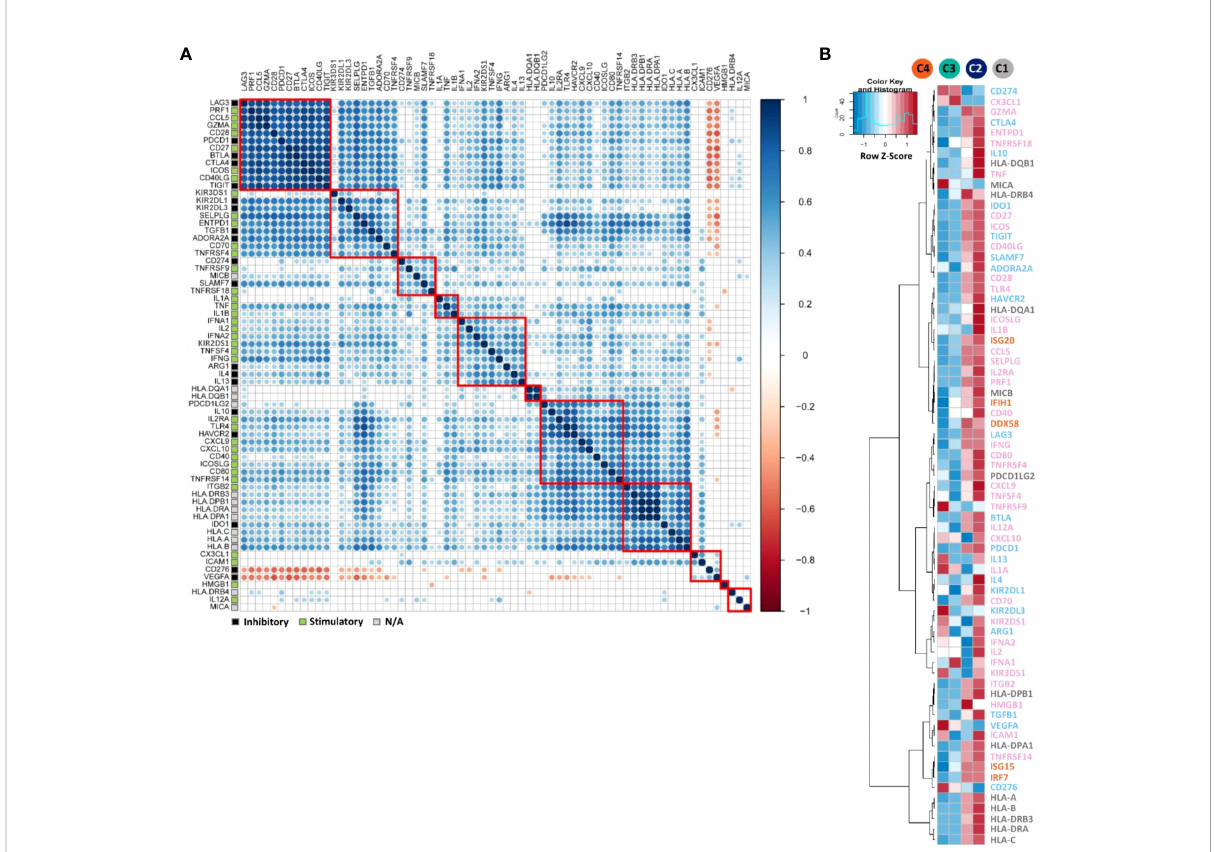
FIGURE 4 Correlation and expression analyses of immunomodulator genes. (A) Pearson correlation matrix showing the clustering and correlations of 68 immunomodulator genes. The correlation matrix was subjected to unsupervised hierarchical clustering using Euclidean distance measurement. Blue dots illustrate positive correlations, white ones no correlation (FDR ≥ 0.01), and red negative correlations. Bigger dot size indicates a smaller p-value of the correlation. Red squares indicate the individual clusters. Different gene modulatory functions were annotated in coloured squares on the left. Black indicates the inhibitory function, green stimulatory and grey modulatory function not known (N/A). (B) heatmap indicating the average mRNA expression of 68 immunomodulator genes together with fi ve genes from long-survival relevant pathways such as RIG-1-like receptors (RLRs) and type 1 interferon pathways, among the four patient clusters C1-C4. mRNA expression data were normalised and unsupervised clustered using Euclidean distance measurement. For the gene expression level, relatively high level expressions are in red, low level in blue. On the right side of the fi gure, inhibitory gene names were marked in light blue, stimulatory ones were in pink, unknown modulatory function genes in grey and RLRs and type I interferon pathway relevant genes in